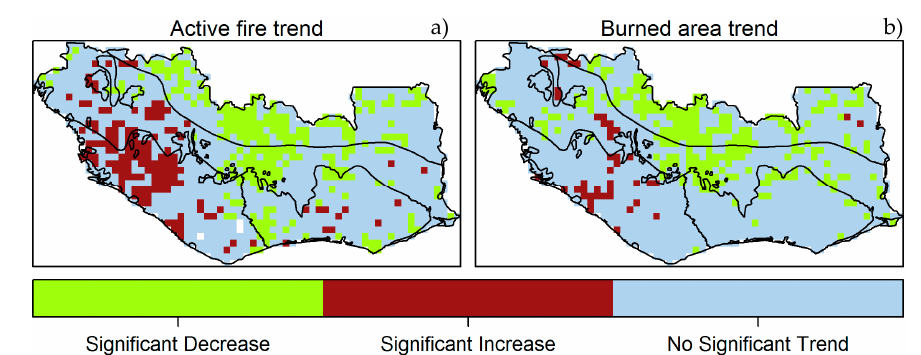
Figure 7. Results of Mann–Kendall trend test of annual: ( a ) MODIS active fire density; ( b ) percent burned area for each grid cell for the period 2003–2015. Cells with p -values less than or equal to 0.1 are highlighted in the maps. Grid cells without enough data points to calculate trend are shown in white. Table 3. Nonparametric Mann–Kendall tests to detect trends in fire activity at ecoregion scale from 2003–2015. Positive Kandall’s tau statistic values indicate increasing trends, whilst negative values indicate decreasing trends.